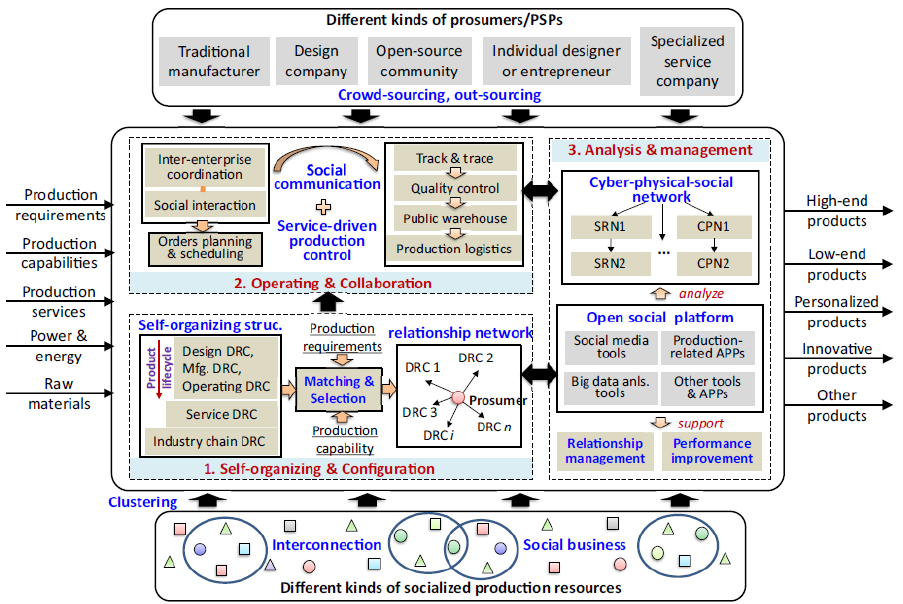
Figure 9. Logic framework of SocialM (see [55]).